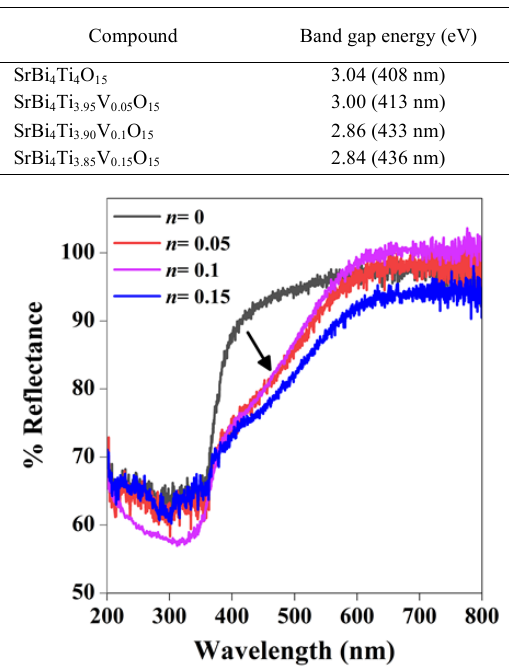
Table 3. The band gap energy values of SrBi 4 Ti 4- n V n O 15 ( n = 0, 0.05, 0.1,